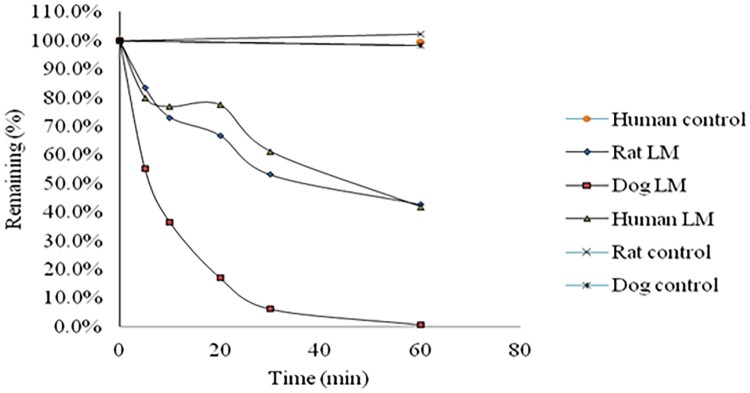
Time-dependent metabolic depletion profiles of NHPPC in rat, dog and human liver microsomes (LM) for: the reaction with NADPH and control without NADPH (% amount remaining vs. incubation time).